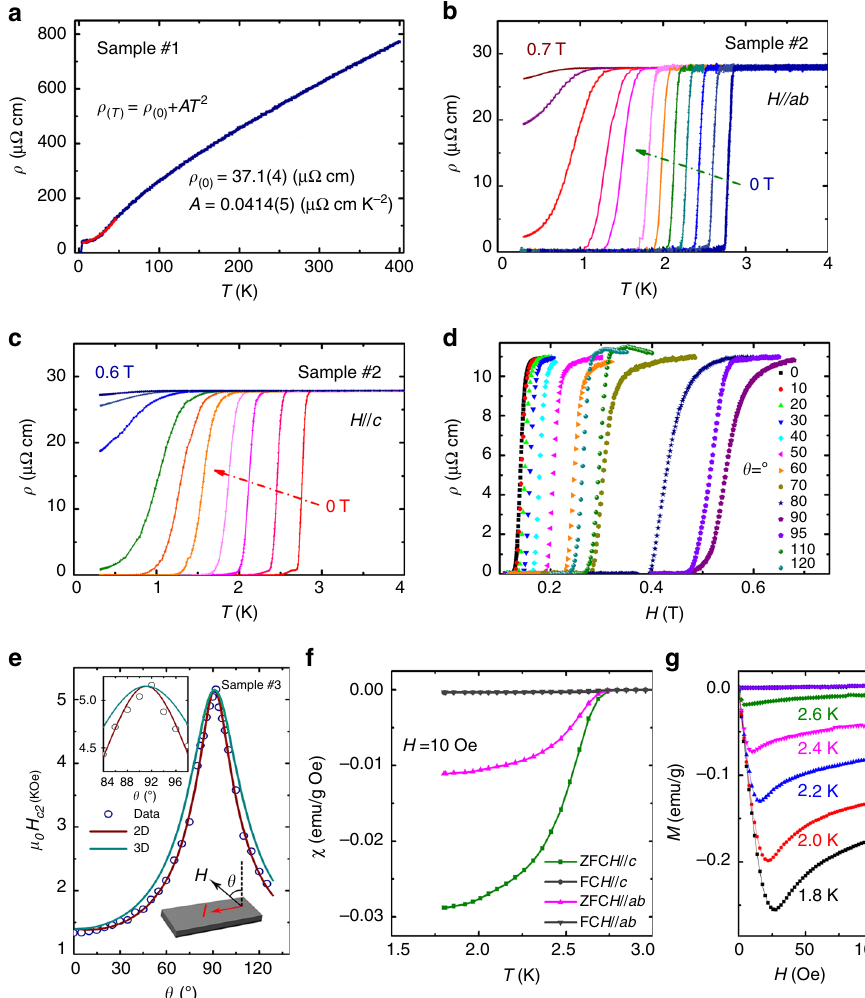
Fig. 4 Transport and magnetic properties of AuTe 2 Se 4/3 . a The electrical resistivity of AuTe 2 Se 4/3 from 400 to 2 K. The quadratic fi tting in the low temperature range exhibits the Fermi-liquid behavior. b , c Superconducting transition of AuTe 2 Se 4/3 along H // ab and H // c under magnetic fi eld. d The magnetic fi eld dependent resistivity of different angles ( θ ) at 2 K. e Angular dependence of the upper critical fi eld μ 0 H c2 ( θ ). The upper inset shows the magni fi ed view of the range near θ = 90°. The θ is the angle between magnetic fi eld and the normal direction of the ab -plane. The lower inset shows the schematic diagram of measurement assembly. The wine and cyan solid lines are the fi tted curves with 2D and 3D model as discussed in the text. f Temperature dependence of magnetic susceptibility ( χ ) with ZFC and FC mode. g The magnetization curves of AuTe 2 Se 4/3 at different